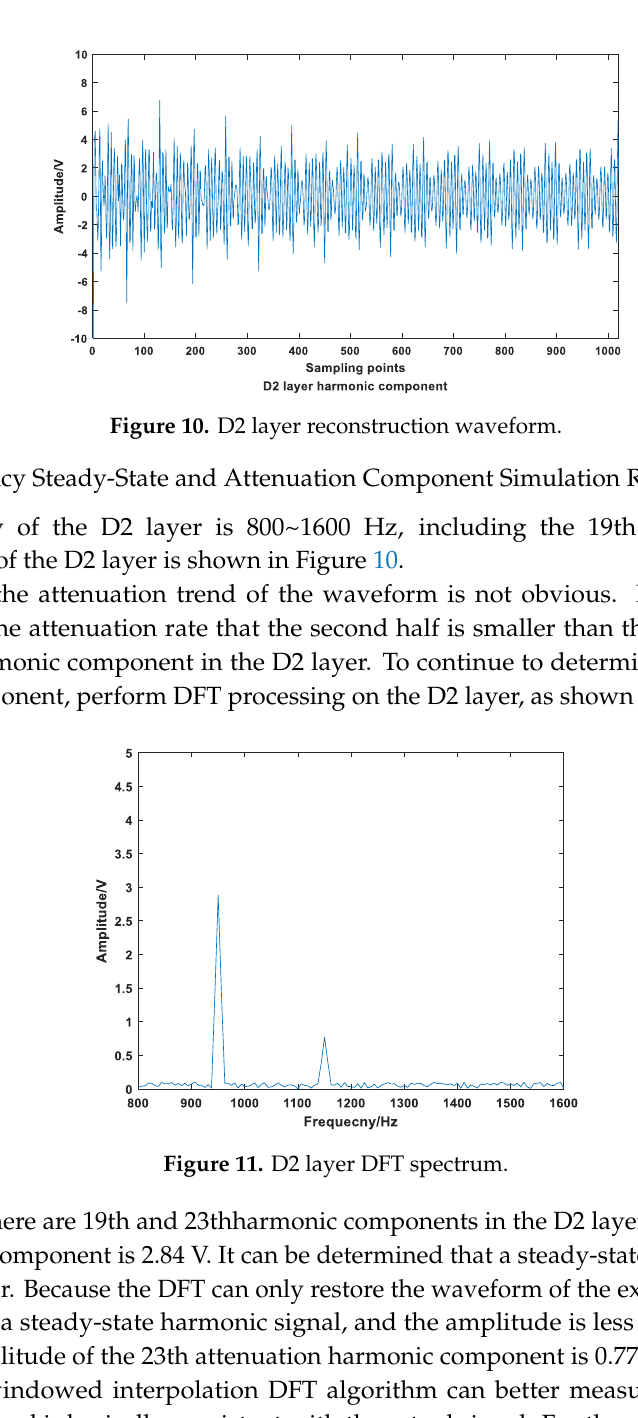
Figure 11. D2 layer DFT spectrum.